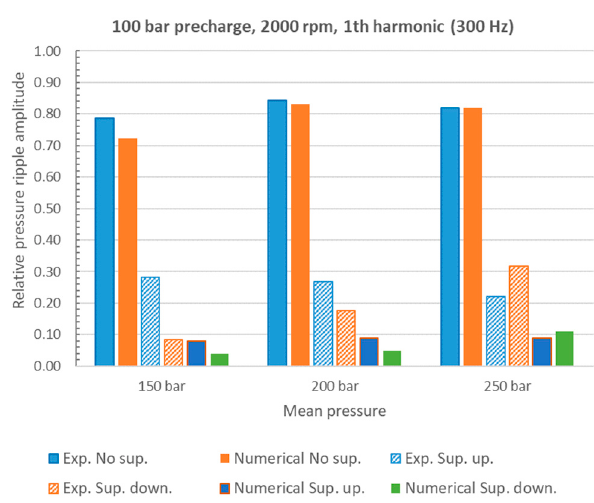
Figure 17. FFT of the pressure ripple, 1st harmonic, pump speed = 2000 rpm.